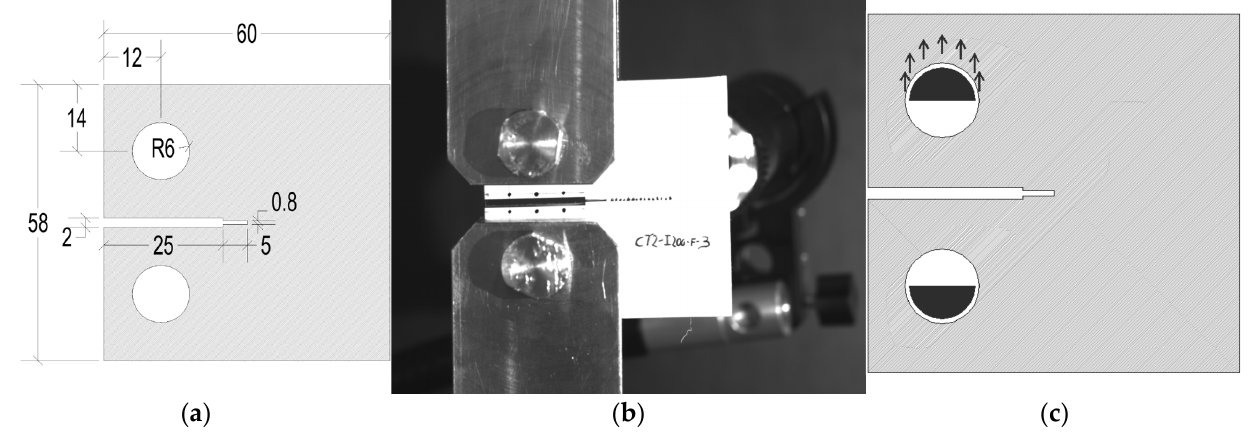
Figure 4. Geometry and test setup for the classical compact tension test (CT) [58]. ( a ) Geometry [mm]; ( b ) experimental layout; ( c ) laboratory conditions.